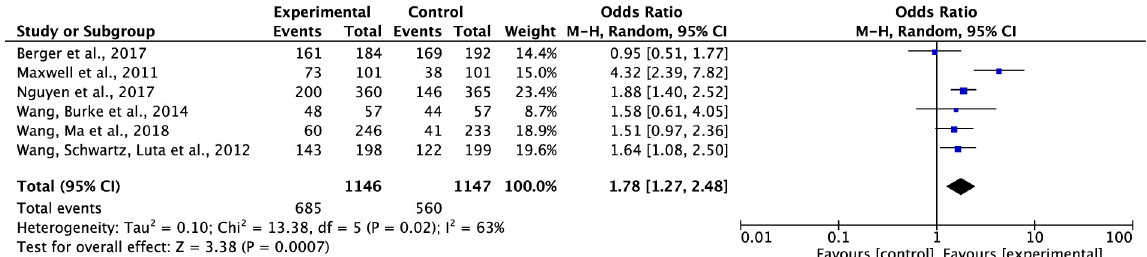
Fig 3. Forest plot of participants’ Intention to complete cancer